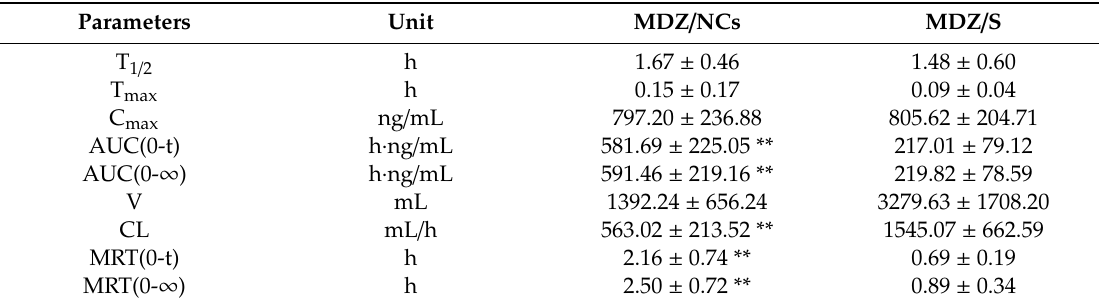
Figure 7. Plasma concentration–time curves for MDZ / NCs and MDZ / S, n = 6. Abbreviations: Nano, MDZ nanocrystals; Solution, MDZ solution. Table 5. Pharmacokinetic parameters of MDZ/NCs-A and MDZ solution after intramuscular